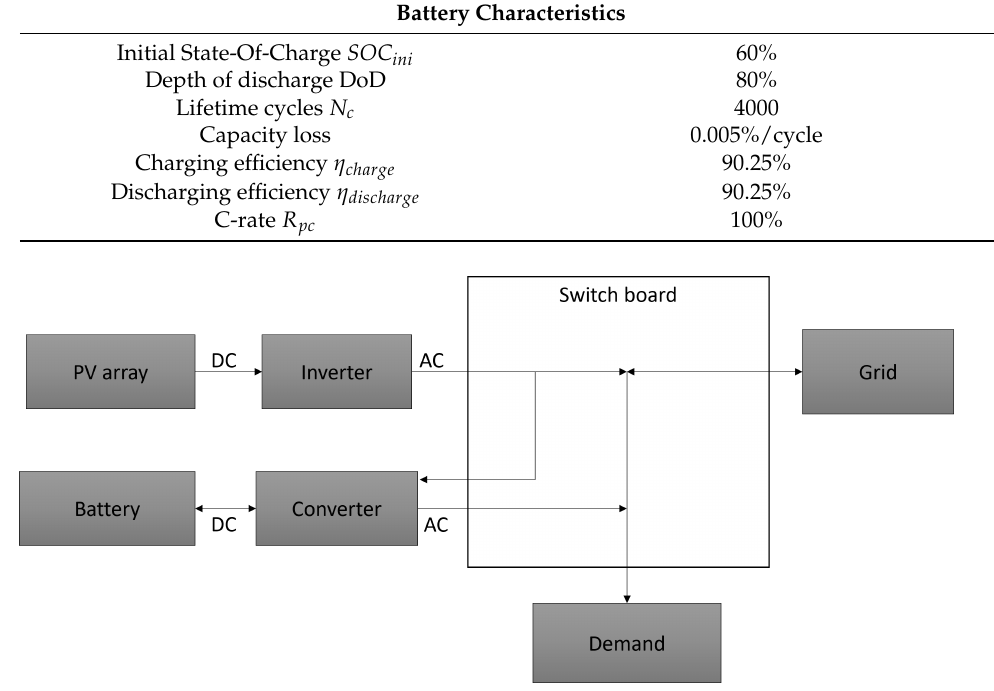
Figure 3. Major components of the